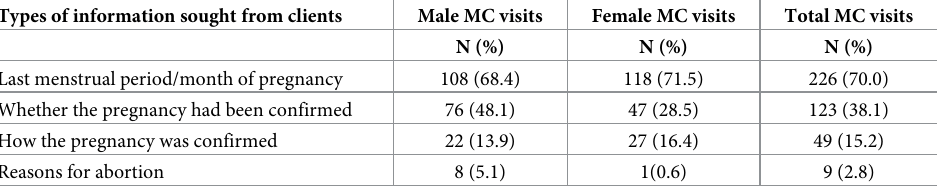
Table 2. Information sought by pharmacy workers when asked for MA drugs (N = 323) (multiple